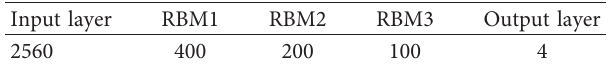
Figure 7: RMSE curve during fine tuning: (a) global and (b) detail. Table 3: DBN structure parameter setting. Table 4: Learning parameter